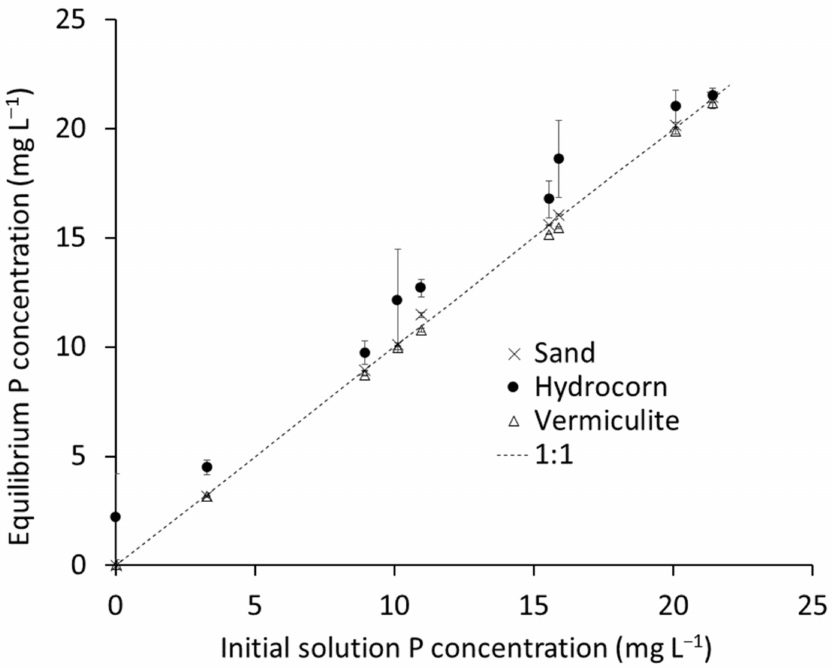
Figure 2. Phosphorus (P) sorption isotherm for silica sand, a commercially available hydroponics media known as “Hydrocorn”, and traditional vermiculite used in greenhouse pots. Dashed line is a 1:1 relationship which indicates zero P sorption or desorption. Error bars indicate standard deviation at n =